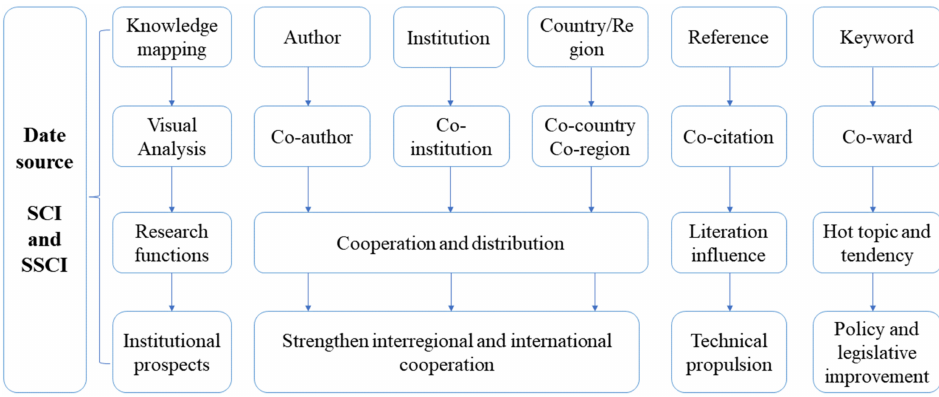
Figure 1. Research roadmap.